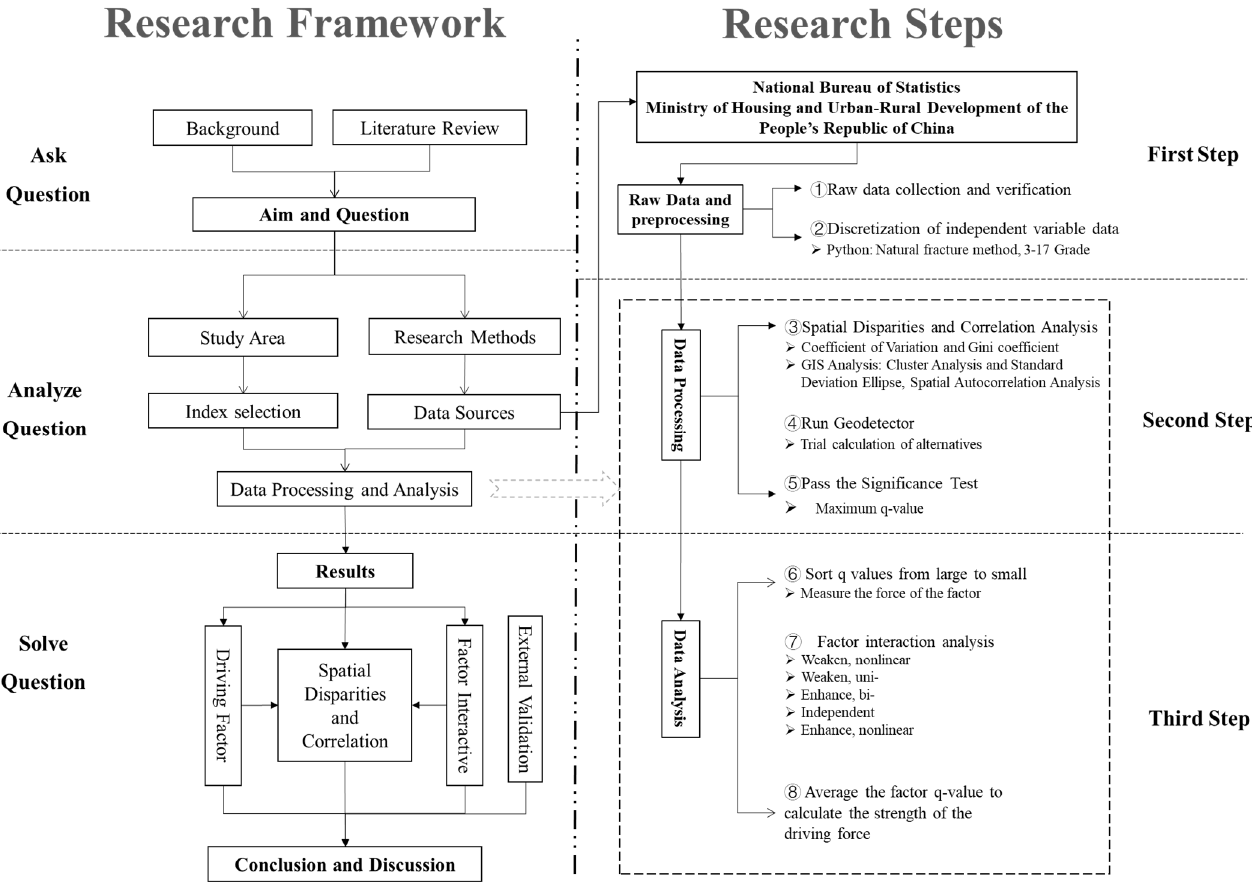
Figure 2. Research framework and steps.